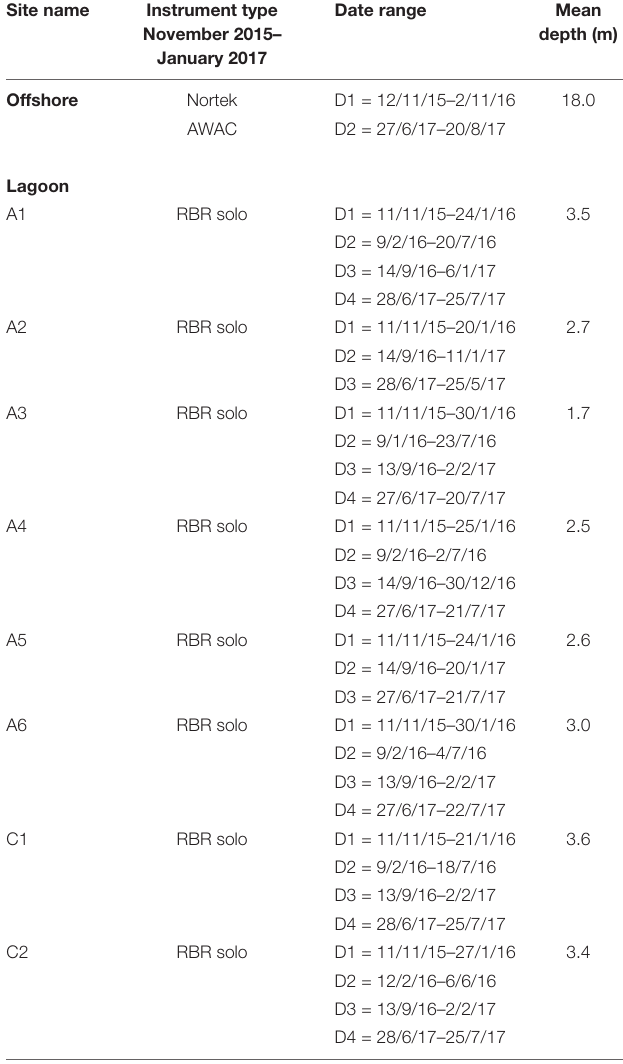
TABLE 1 | Site names, instrument type, and approximate mean depth during the study